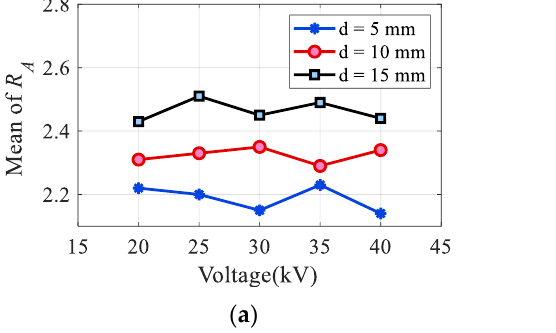
Figure 9. Ratio relationship between the positive amplitude and negative amplitude at different voltages: ( a ) average values; ( b ) STDs.